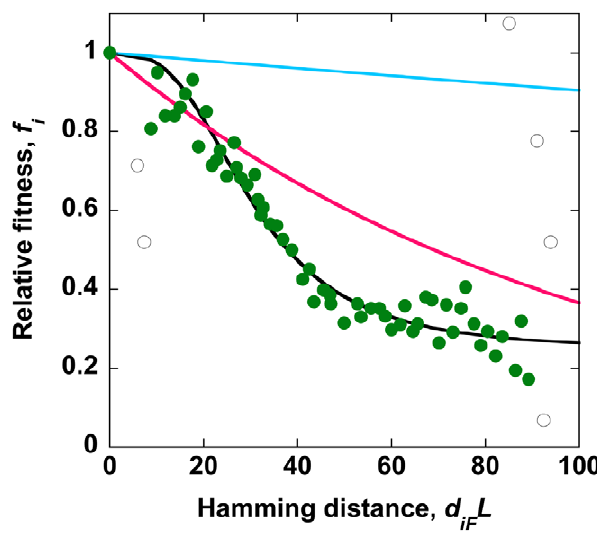
Figure 10. Fitness landscape. The relative fitness, f i , of genomes as a function of their Hamming distances from the fittest sequence, d iF L , obtained from experimental observations [37] (symbols) modified to account for the ratio of synonymous and non-synonymous substitutions (Methods) and predicted (black line) by the equa- d iF ð Þ n , with the best-fit parameters tion f i ~ 1 { 1 { f min ð Þ d iF ð Þ n z d 50 ð Þ n f min =0.24, d 50 L =30, and n =3 obtained upon ignoring outliers (open symbols). Multiplicative fitness landscapes, f i ~ exp( { sd iF L ) , with s =0.001 (cyan) and 0.01 (pink) are also shown.